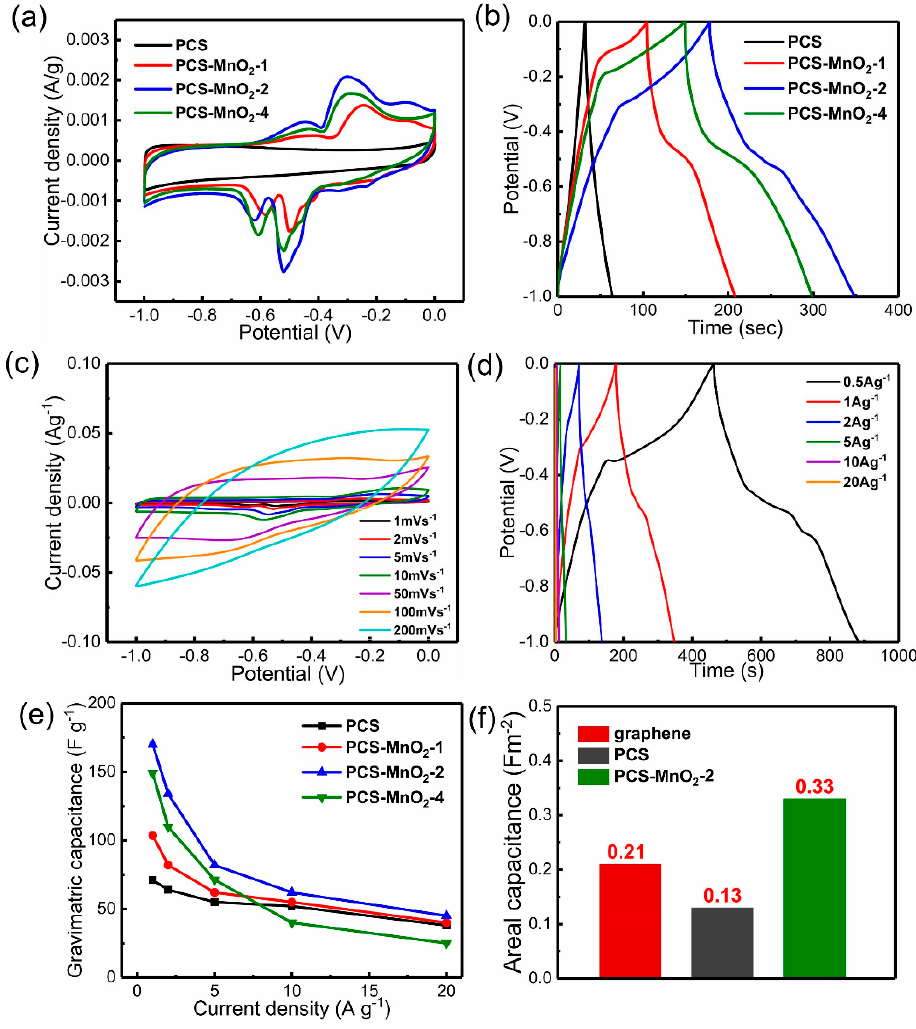
Figure 5. Electrochemical performance of PCS, PCS-MnO 2 composites in 6 M KOH electrolyte in the three-electrode test system: ( a ) CV curves tested at a scan rate of 1 mV s − 1 , ( b ) GCD curves tested at the current density of 1 A g − 1 . ( c ) CV curves of PCS-MnO 2 -2 at the scan rate in the range of 1~200 mV s − 1 ,